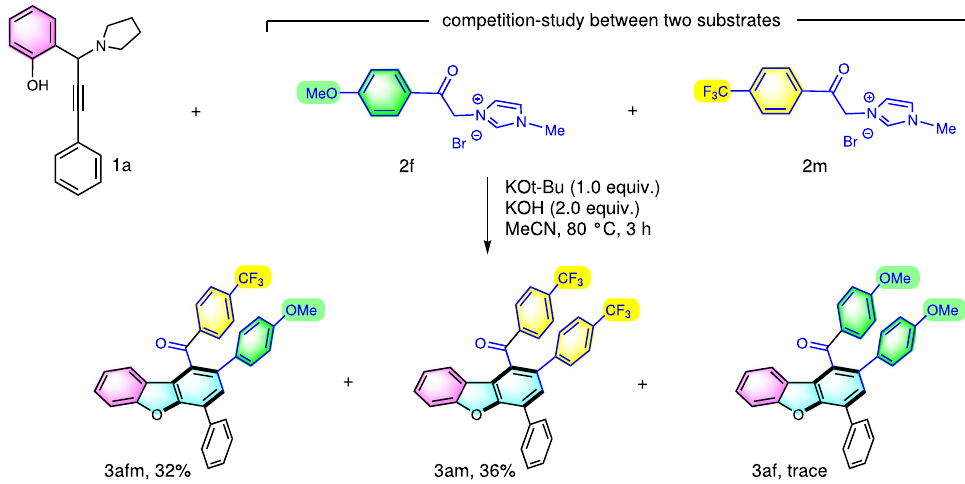
Fig. 4 A competition experiment. A competition-study between two electronically different imidazolium methylides 2f and 2m were